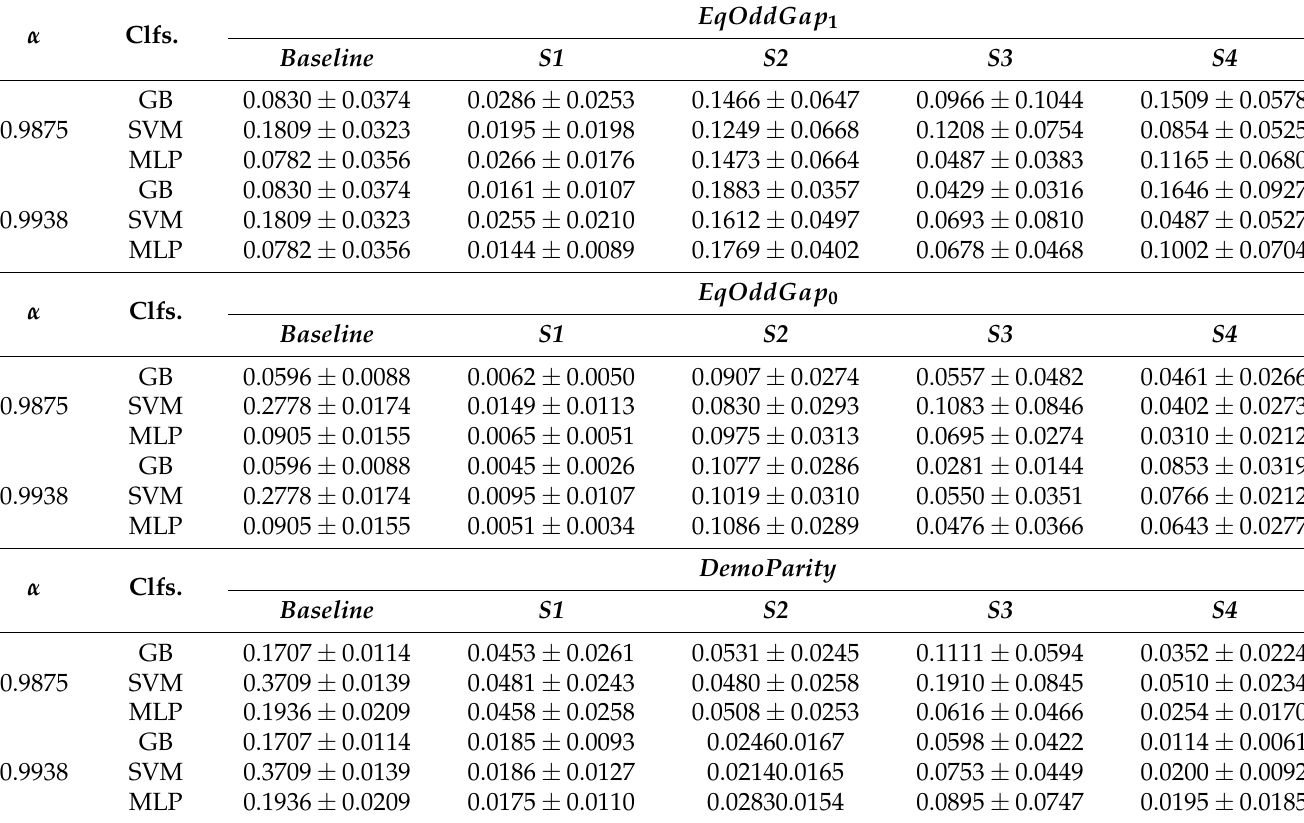
Table A1. Equalized odds and demographic parity on